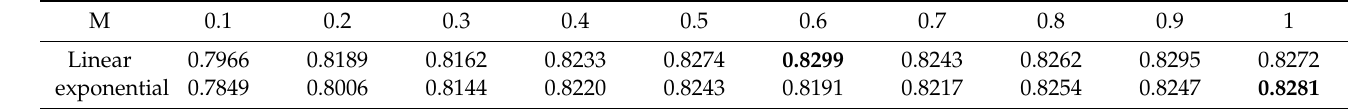
Table 2. AdCB with different asymptotic behavior and transformation speed.